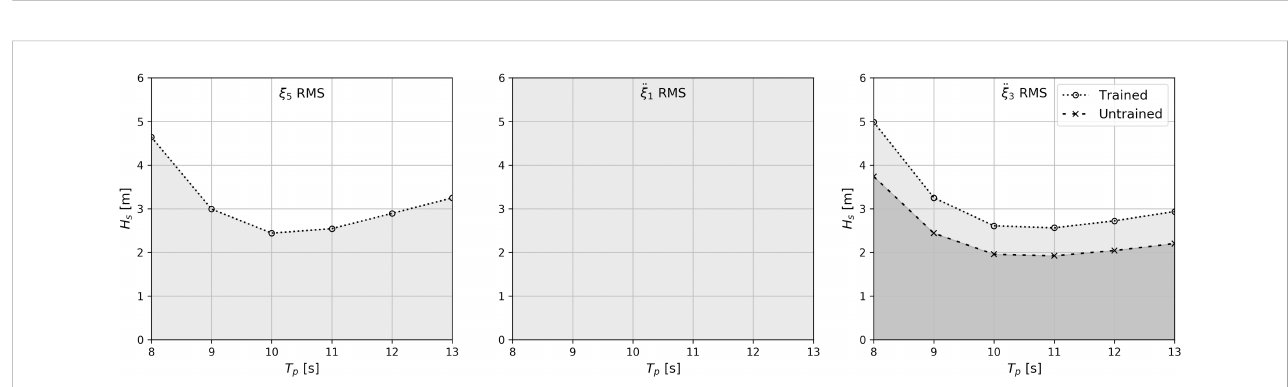
FIGURE 15 Sea conditions under normal operation for the limiting pitch ( x 3 (RMS) ) of 2deg, as well as the corresponding horizontal (¨ x 1 ) and vertical (¨ x 3 ) accelerations of B16 for various H s with different T p . Here the light gray region identi fi es the operational seaways for experienced workers; gray region, untrained